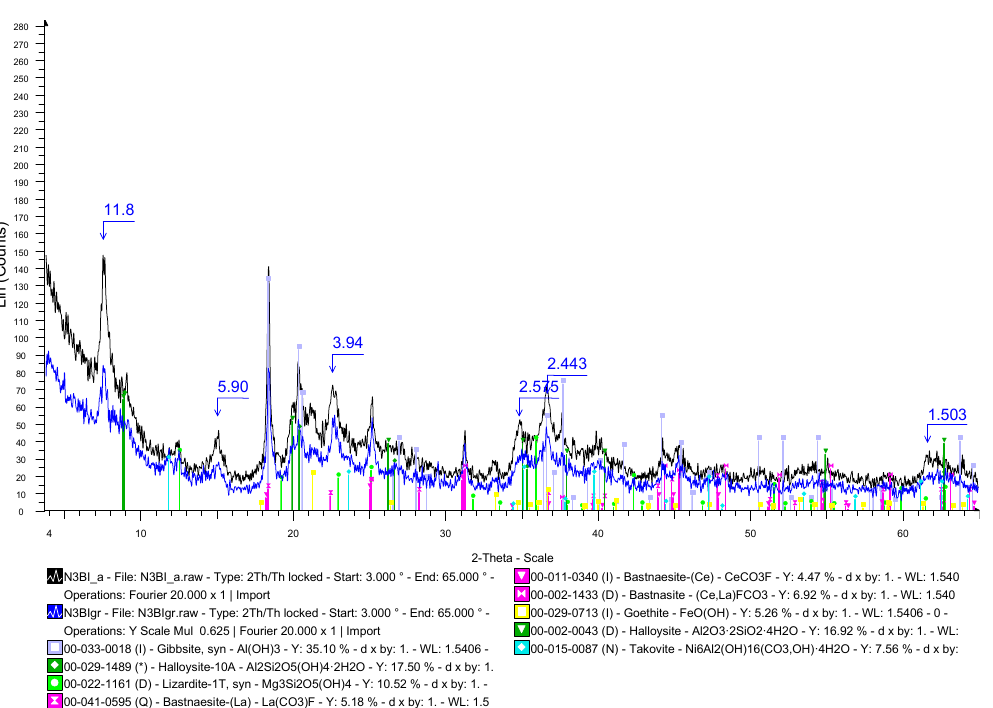
Figure 6. X-ray powder diffraction (XRD) pattern of a Ni-rich bauxite laterite sample (NB group of samples) from the contact between the lowermost part of the bauxite laterite ore and the carbonate basement. Reflections recorded at 11.8 Å, 5.90 Å, 3.94 Å, 2.575 Å, 2.443 Å, and 1.503 Å are attributed to the unknown Al–Ni–silicate mineral.